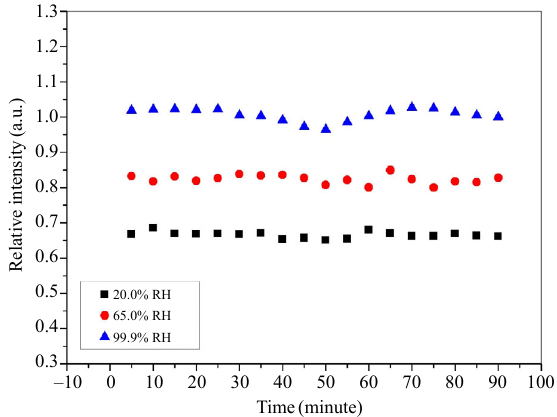
Fig. 11 Stability test results of the proposed sensor at three different RHs.